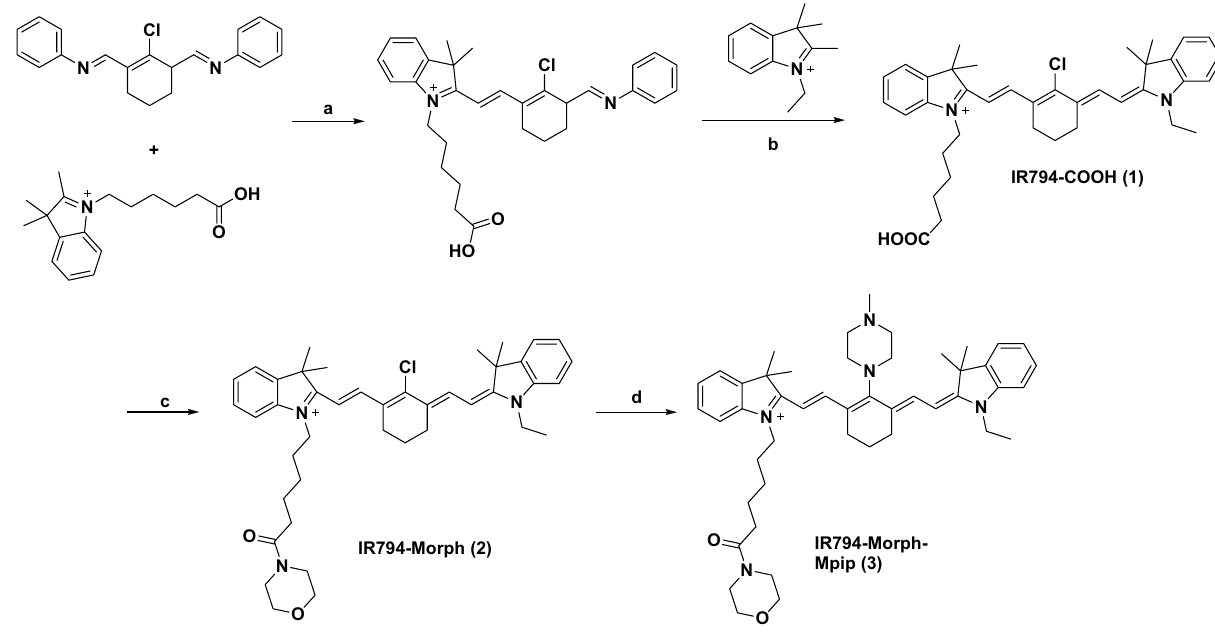
Figure 1. Syntheses of IR794 derivatives. Reagents: ( a , b ) NaOAc, EtOH, 80 °C, 2 h 37 . ( c ) Morpholine, EDC. HCl, DMAP, CH 2 Cl 2 , 0 °C, under N 2 , 2 h 38 . ( d ) N -methylpiperazine, DMF, 25 °C, under N 2 , 3 h 39